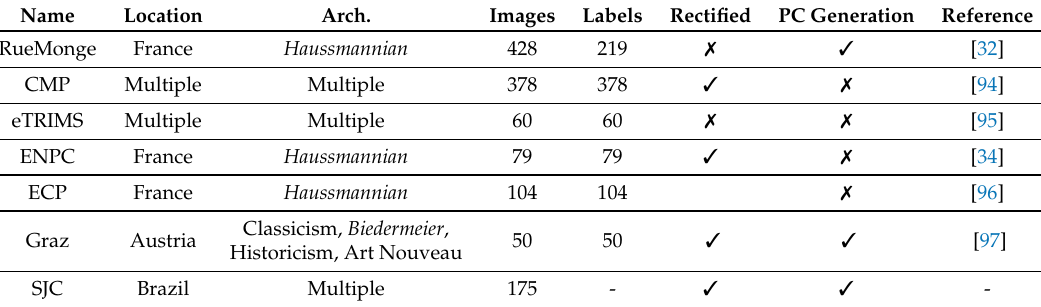
Table 1. Datasets for façade analysis and benchmarks. RueMonge2014 and Graz, ETH Zürich; CMP, Center for Machine Perception; eTRIMS, University of Bonn; ECP, Ecole Centrale Paris; SJC, São José dos